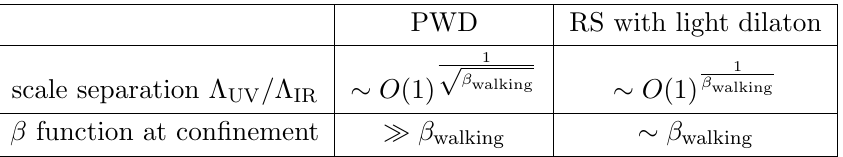
Table 2 . Comparison between the perturbative walking dynamics (PWD) model with RS-like models of spontaneous con(cid:12)nement.